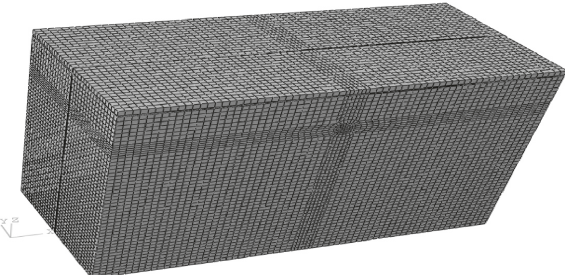
Figure 1: 3D finite element mesh for the